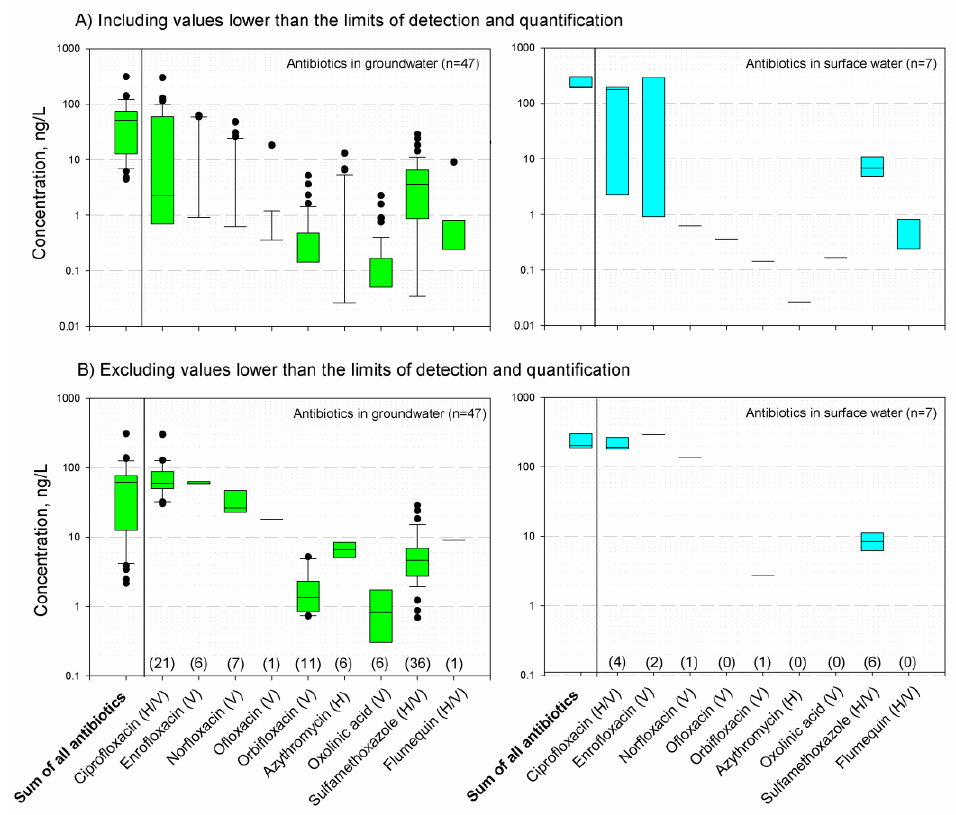
Figure 2. Distribution of the most frequent antibiotics detected in groundwater and surface water in the Baix Fluvià aquifer. The upper plots ( A ) include those samples with analytical values lower than analytical limits, to which a value of two-thirds of the detection limit was assigned. The lower plots ( B ) exclude these samples, and the numbers in parenthesis indicate the numbers of samples with measurable concentrations. H and V indicate human and veterinary use. Table 2. Results of the Redundancy Analysis (RDA). The “raw data” caption assumes that data has been transformed as mentioned in Section 2.3. Legend: See variable explanation in Table 1 and flow chart in Figure